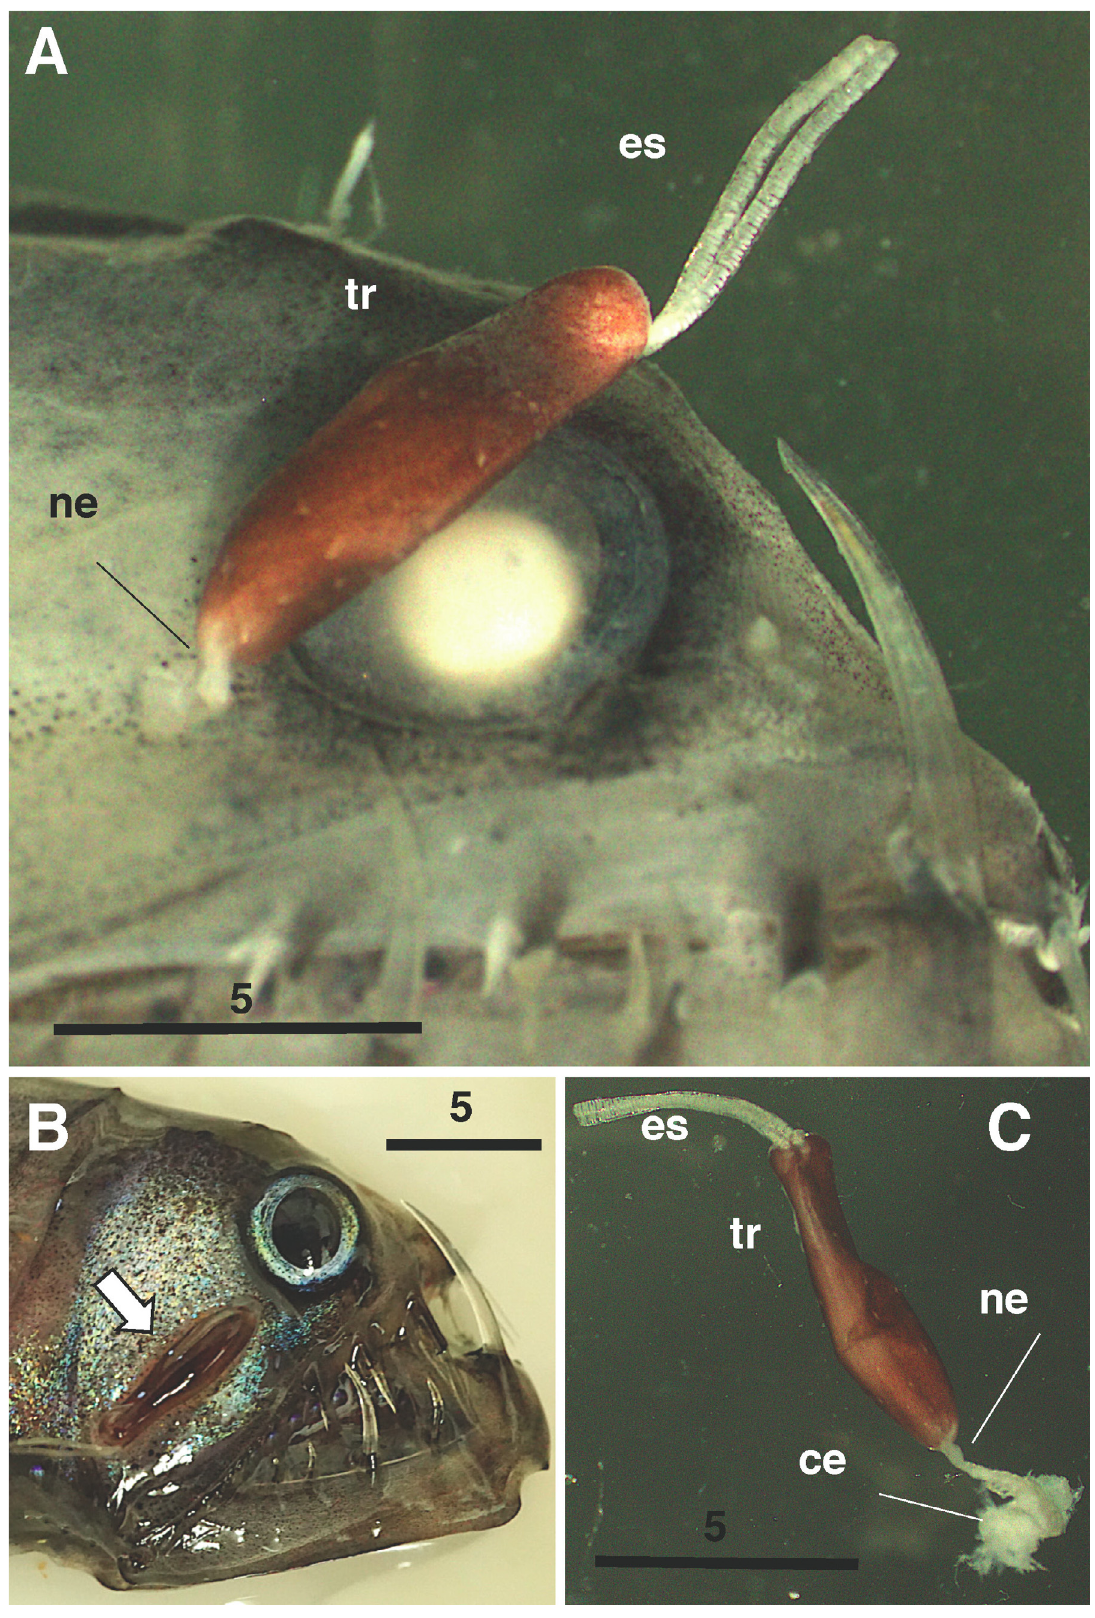
Figure 1. Protosarcotretes nishikawai n. g., n. sp., adult female (holotype). A. whole specimen, in-situ on host, after fi xation; B. whole specimen (arrowed), in-situ on host, before fi xation; C. whole specimen, dissected out of host. Abbreviations: ce: cephalothorax, es: egg string, ne: neck, tr: trunk. Scales in